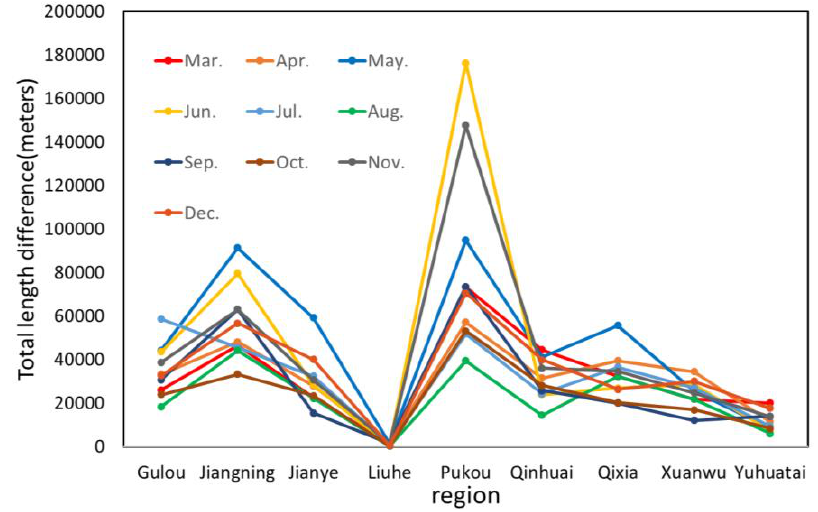
Figure 10. The total length of street segments which are assigned to different fire stations in administrative regions across the time.